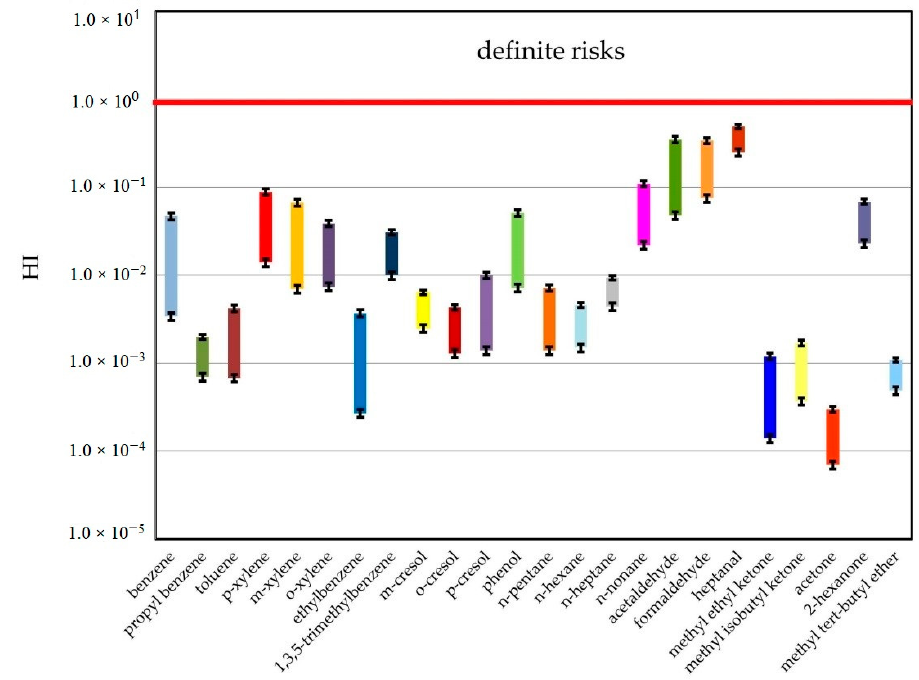
Figure 3. Ranges of hazard index (HI) parameter determined based on investigations performed in both 2017 and 2018.